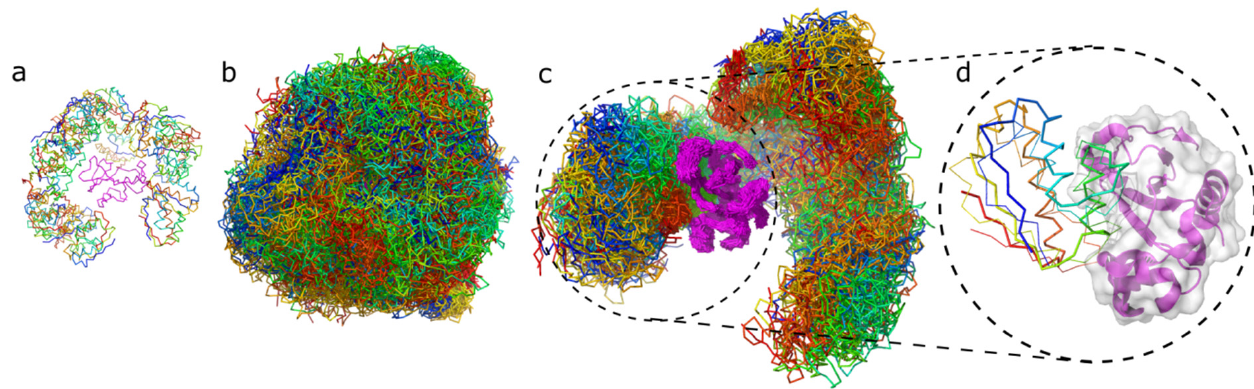
Figure 2. Protein–protein docking stages illustrated by barstar/barnase docking case. The figure shows the barnase receptor in magenta and the barstar ligand in rainbow colors. The respective panels show: ( a ) 20 starting structures for each replica of the system; ( b ) 10,000 models combined from 20 replicas (500 models per replica) in which the highly flexible ligand is covering the entire surface of the flexible receptor; ( c ) 500 models from one replica only, ( d ) the best model obtained for barnase/barstar system (the X-ray structure of the ligand is shown in thick ribbon, the modeled in thin ribbon).